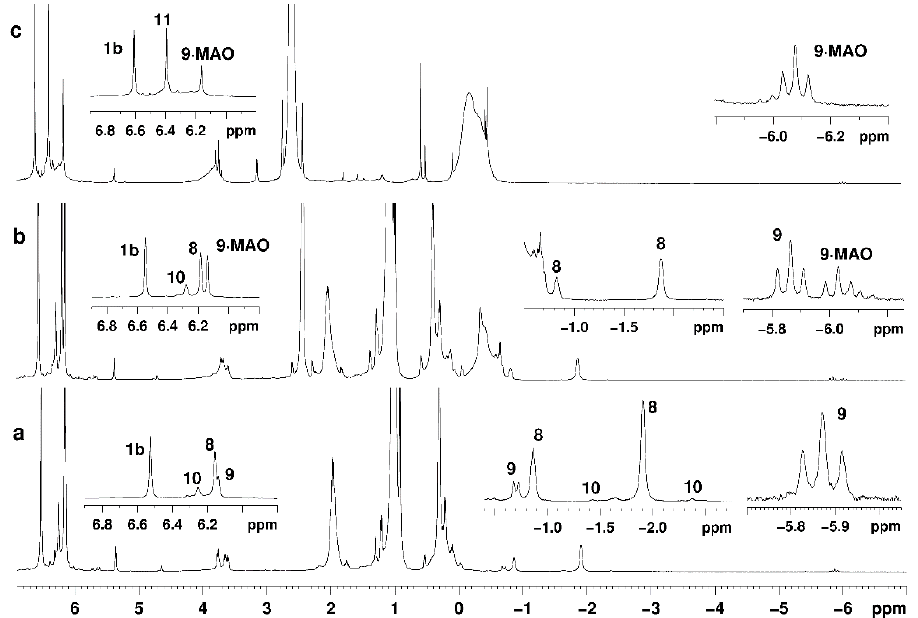
i 2 ZrH 2 ] 2 -ClAlBu 2 -MMAO-12 in CD 2 Cl 2 (T = 298